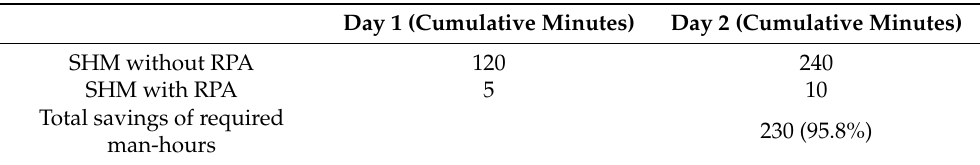
Table 5. Man-hour savings during the monitoring process.